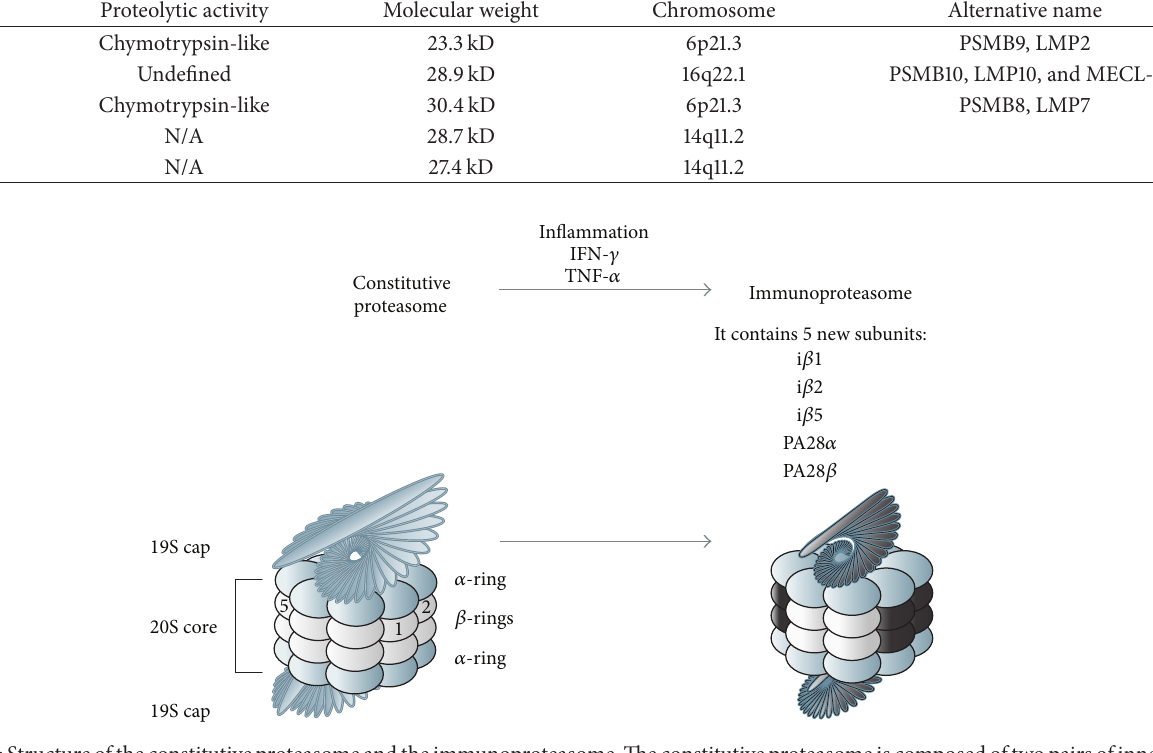
Figure1:Structureoftheconstitutiveproteasomeandtheimmunoproteasome.Theconstitutiveproteasomeiscomposedoftwopairsofinner 𝛽 -rings,twopairsofouter 𝛼 -rings,andtwocaps(19Sregulatorycomplexes).Inflammatorycytokinesinducetheexpressionofthefivesubunits (i 𝛽 1 [LMP2], i 𝛽 2 [LMP10], i 𝛽 5 [LMP7], PA28 𝛼 , and PA28 𝛽 ), which assemble on the proteasome core to create the immunoproteasome.